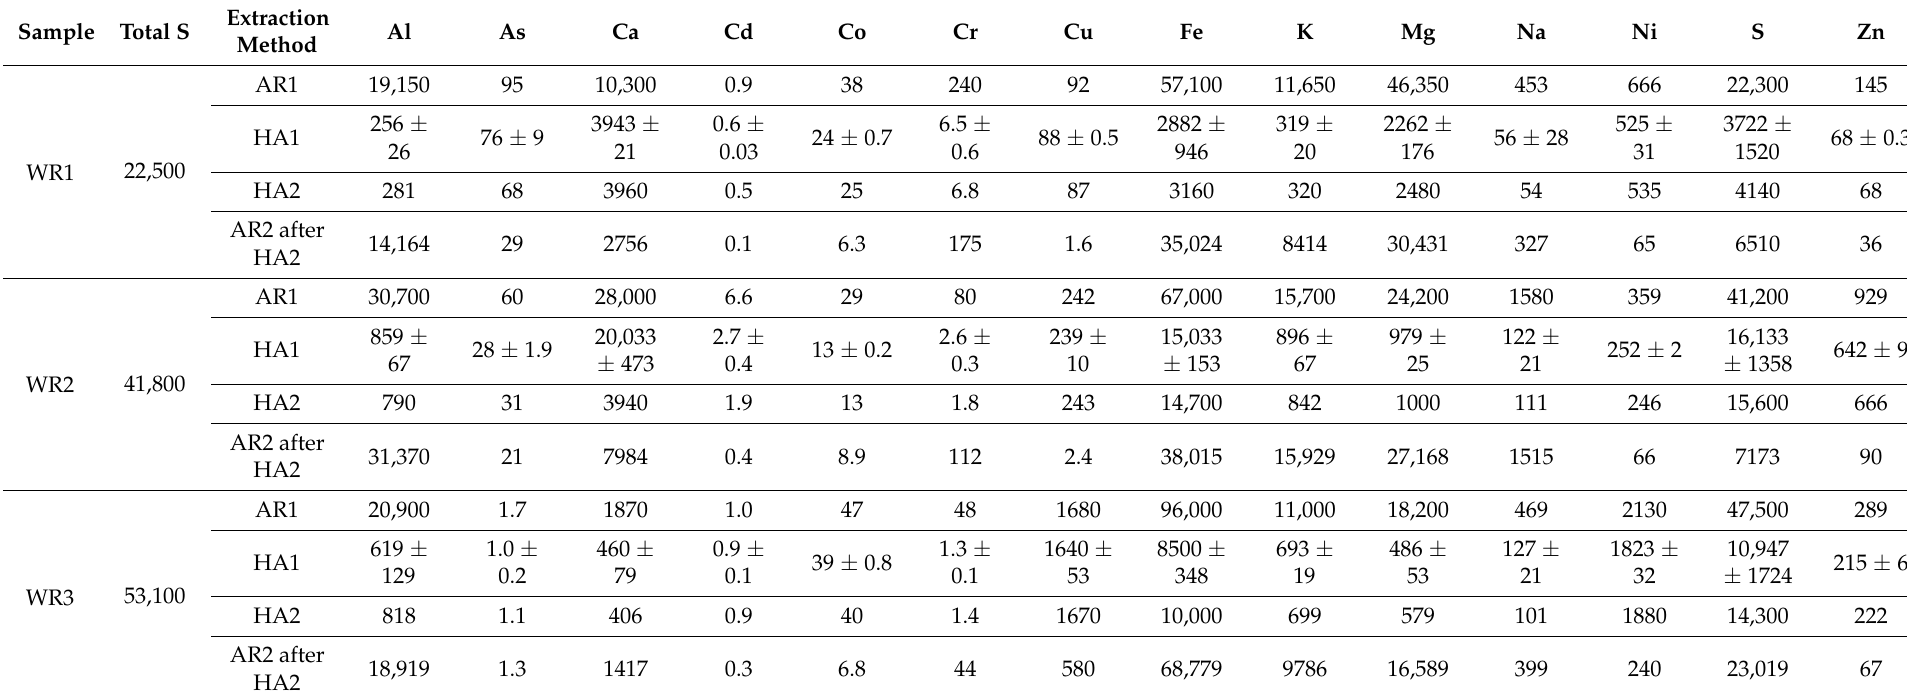
Table 3. Total sulfur and the geochemical extraction results (mg/kg) of Al, As, Ca, Cd, Co, Cr, Cu, Fe, K, Mg, Na, Ni, S and Zn. AR = aqua regia, HA1 = H 2 O 2 -ammonium citrate extraction with normal sample amount, HA2 = H 2 O 2 -ammonium citrate extraction with large sample amount. Three parallel analysis were performed for HA1, these values are presented as averages of the three measurements ± standard deviation ( n = 3). AR2 (which was made for the residue of the HA2) results were adjusted for the original sample mass by a correlation factor (mass of residue / mass of original